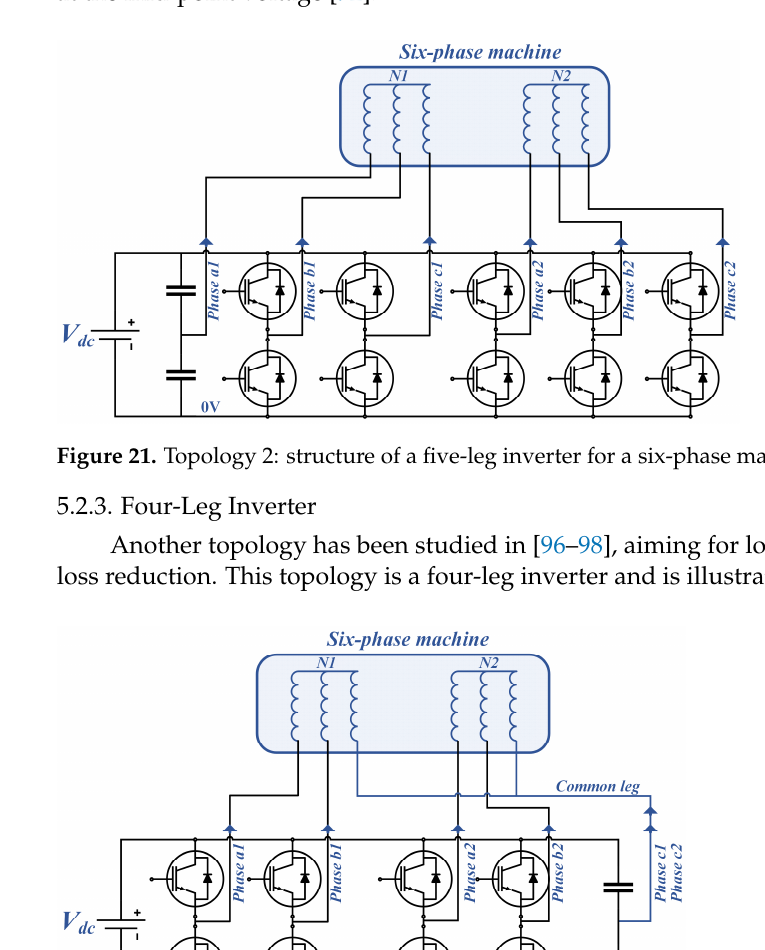
Figure 20. Topology 1: Structure of a five-leg inverter for a six-phase machine.